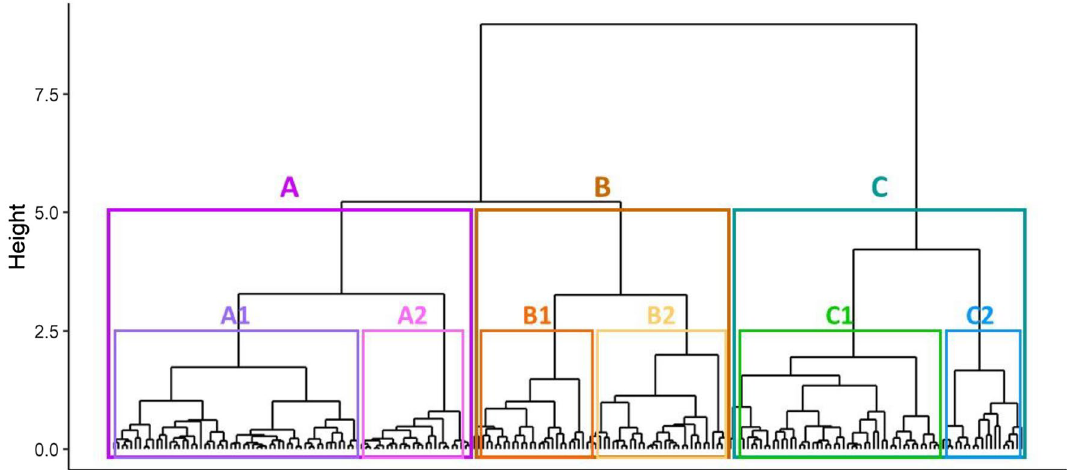
Figure 1. Relationship between the individuals (bottom line) characterised by their factor scores described by a dendrogram of hierarchical cluster analysis with Ward’s